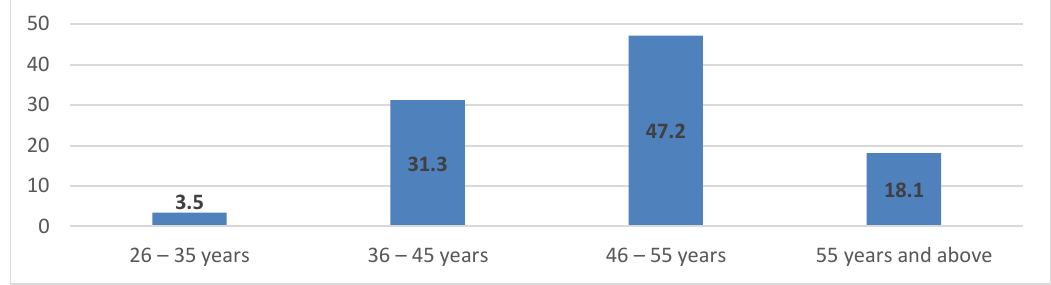
Figure 4: Age Group of Respondents; Source: Survey Data (2023)